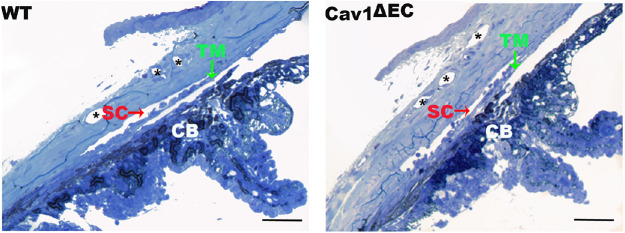
Structural analysis of CO pathway in Cav1ΔEC and WT. Light microscopy of iridocorneal angle structures in semi-thin sections of WT (left) and Cav1ΔEC (right) mice stained with methylene blue. The angle is open in both genotypes. There were no visible abnormalities on gross morphology in the CO pathway structures. CB, ciliary body. *Distal vessels. Scale bars = 50 µm.